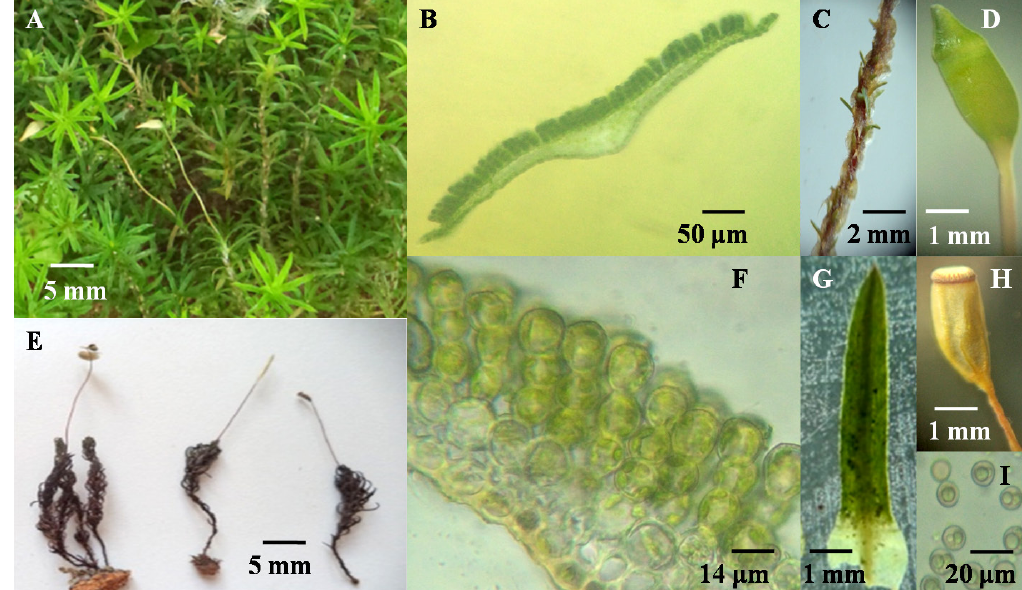
Figure 10: Pogonatum subtortile (Müll. Hal.) A. Jaeger (A) female gametophytes with sporophytes (B) transverse section of lea (C) lower part of stem (D) fresh capsule (E) dry female gametophytes (F) part of transverse section of leaf (G) vegetative leaf (H) dry capsule (I)